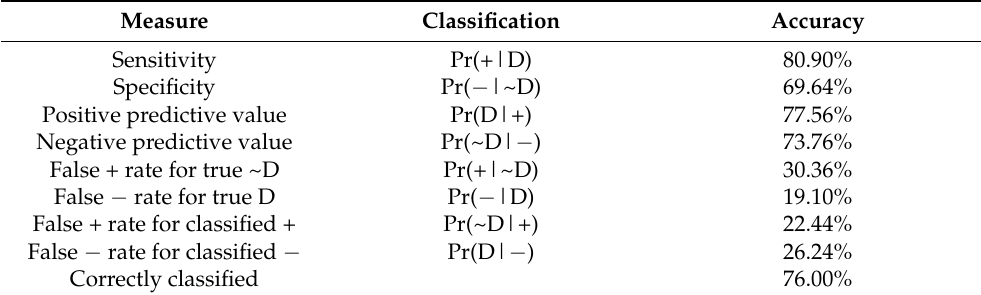
Table 8. Sensitivity, specificity, positive and negative predictive values of the logistic regression